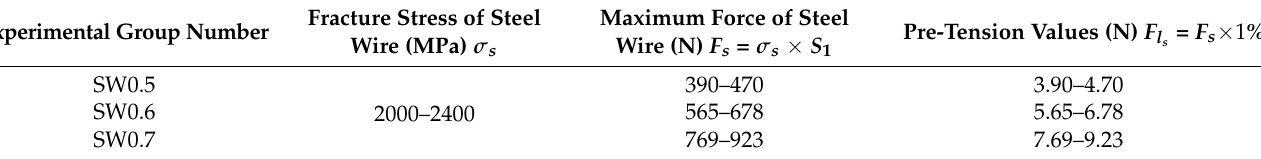
Table 2. Test pre-tension values of cold-drawn non-alloy steel wires for springs.